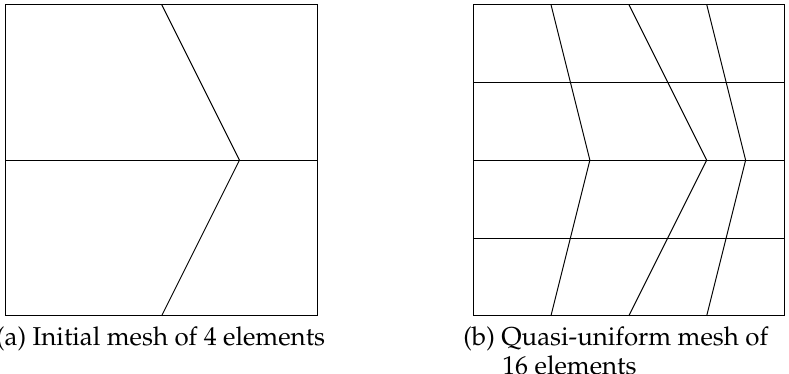
Figure 15. Mesh B: Discretizations with distorted elements